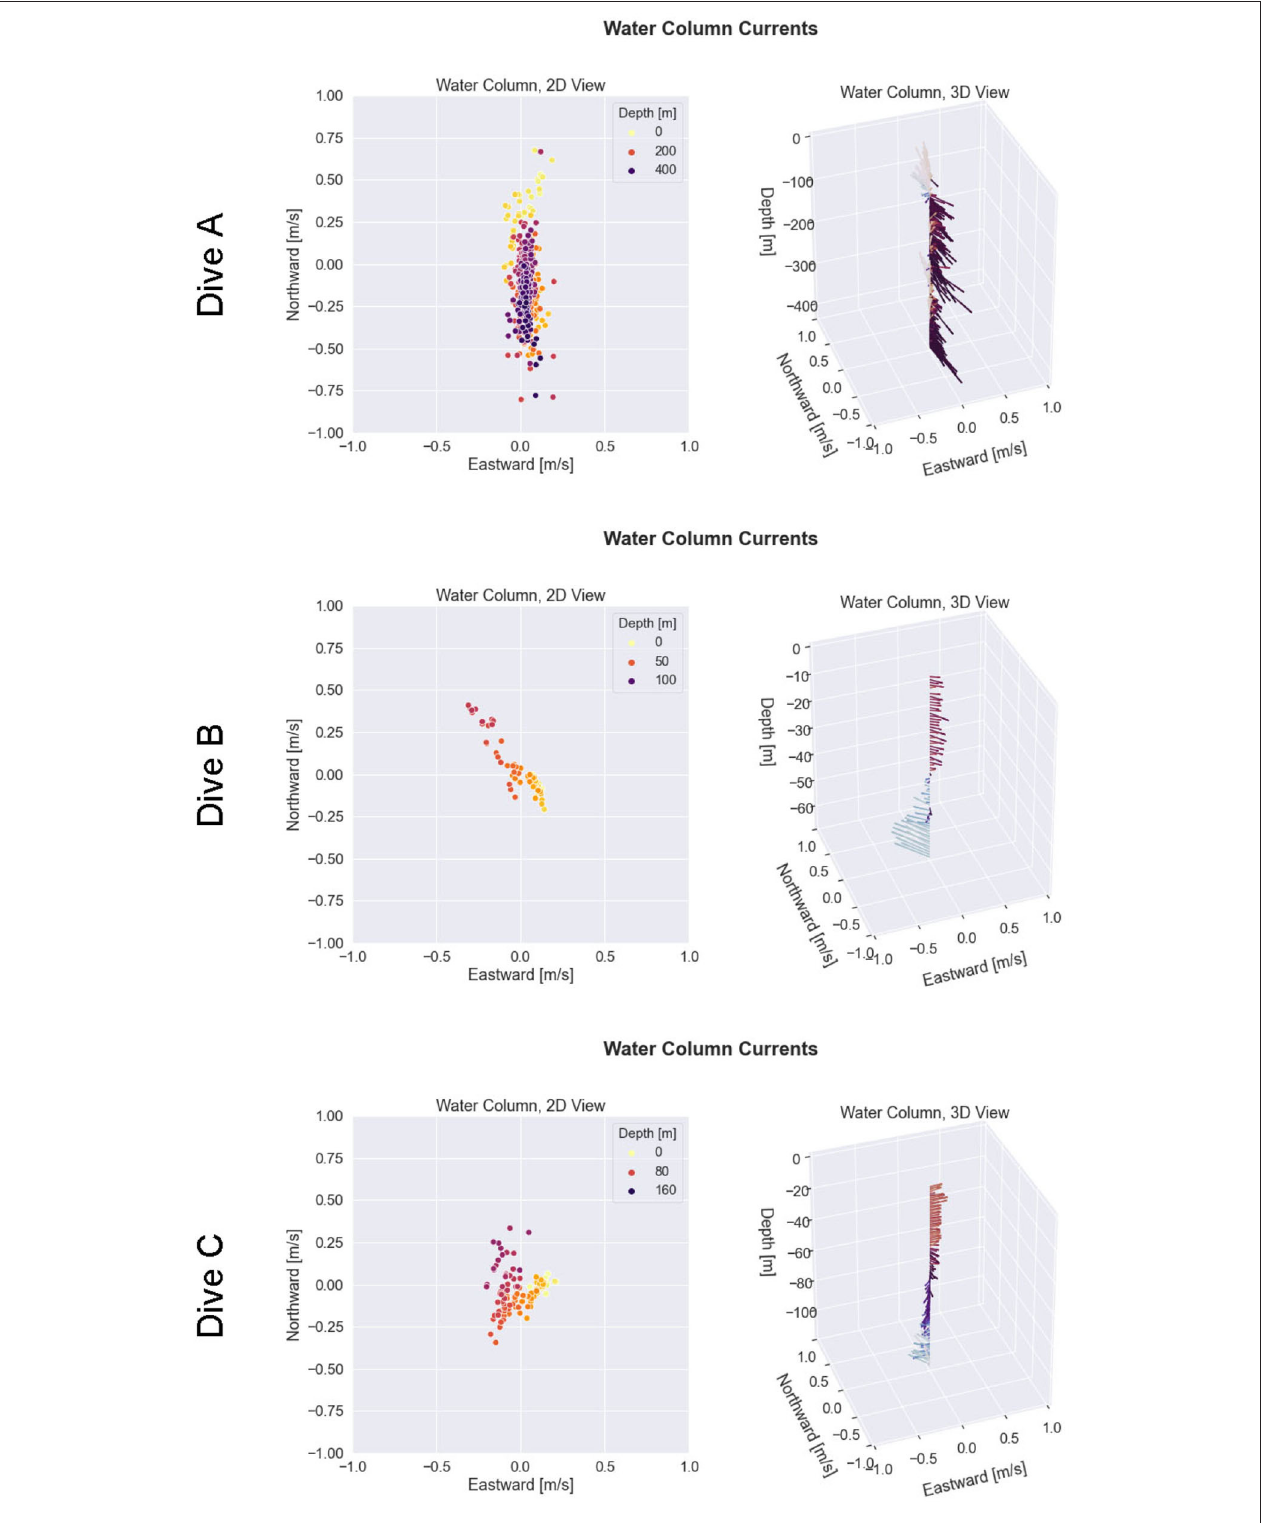
FIGURE 10 | Post-process reconstruction of water column currents for the glider missions shown in Figure 9 . Each row of the figure corresponds to a particular glider mission. The first column shows the observed water column currents in a 2D view. The second column shows the observed water column currents in a synoptic 3D